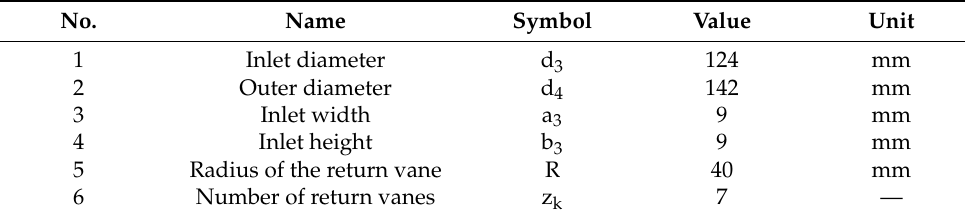
Table 2. Characteristic dimensions of the A4 stator of the model pump (Figures 5 and 6).